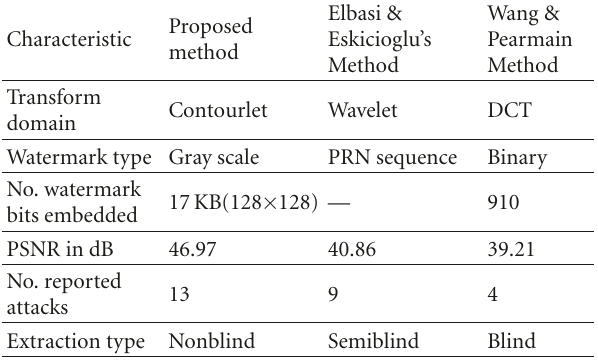
Table 6: Comparison of the proposed method with other domain